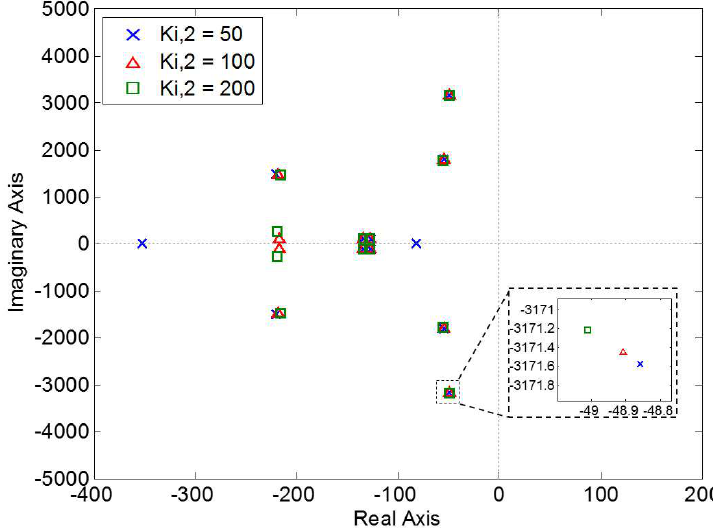
Figure 15. Poles of 1/ ( Y g + Y eq ) when the integral gain of the additional converter parameter